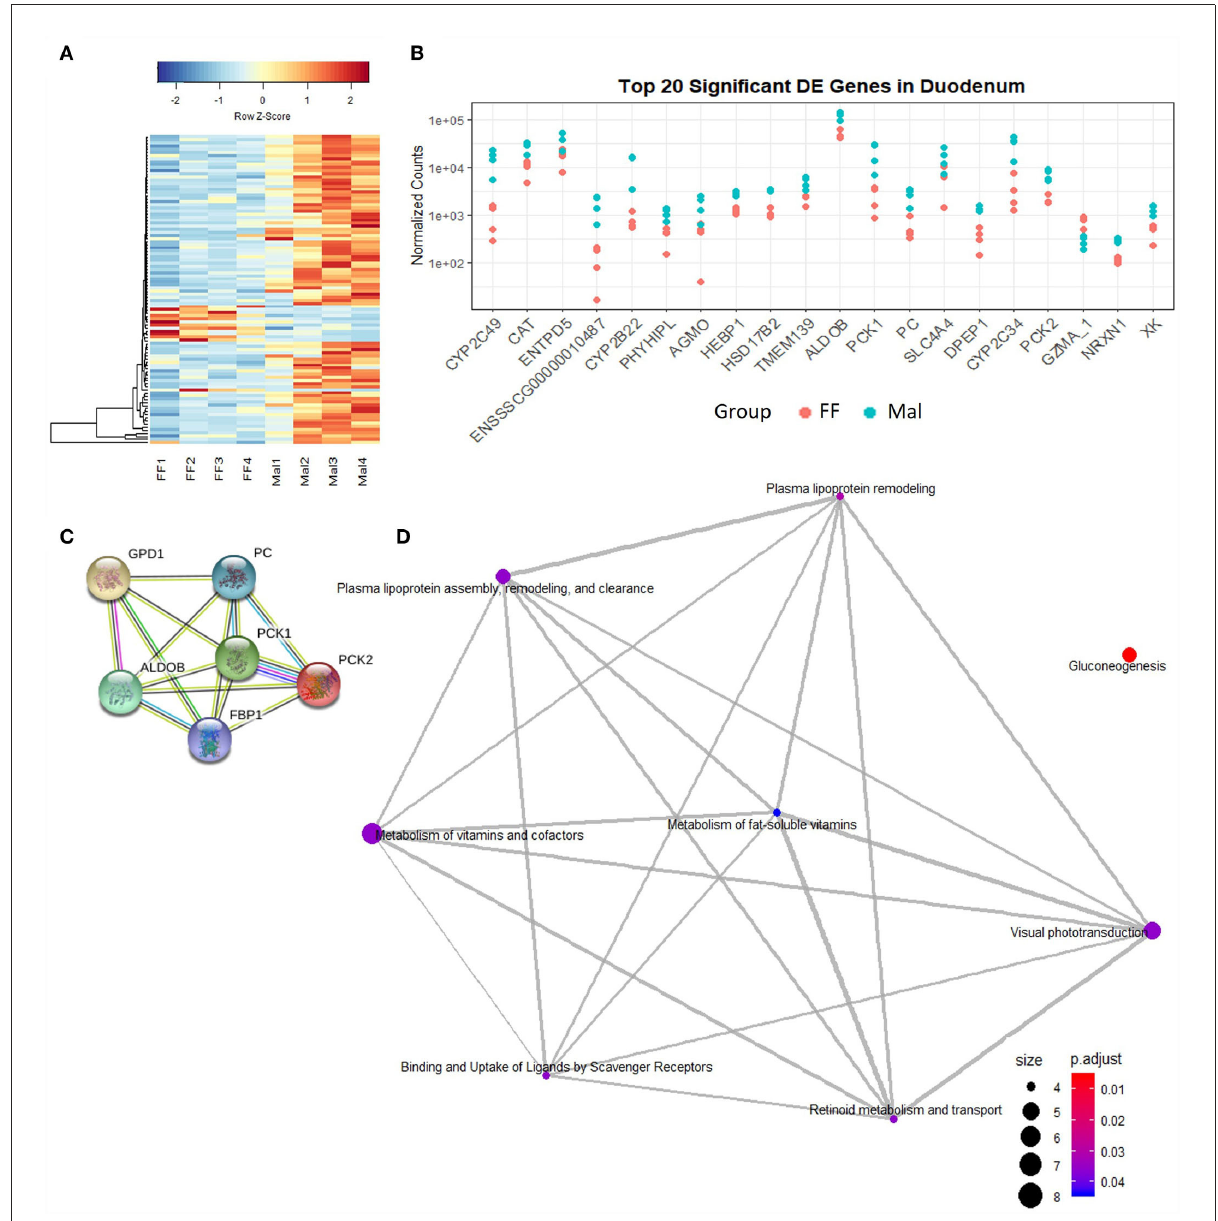
FIGURE2 Gene expression and pathway analysis in the duodenum of full-fed and malnourished pigs. (A) Heatmap with hierarchical supervised clustering of the normalized counts using Euclidean distance for the 100 DE genes with the greatest variance between the full-fed (FF, n = 4) and malnourished (Mal, n = 4) groups in the duodenum. Z-score represents upregulated (red) and downregulated (blue) genes, with a color gradient indicating expression level. (B) Plot of the normalized counts of the 20 genes with the lowest padj values in the duodenum of FF [ n = 4 (pink)] and Mal [ n = 4 (blue)] animals. The genes are ordered left to right from lowest to greatest padj values. (C) Pathways significantly enriched in the duodenum when comparing the FF and Mal groups using GO and STRING functional analysis of upregulated genes associated with gluconeogenesis. Edge colors represent connection source: text mining connection (yellow), co-expression (black), curated databases (light blue), and experimentally determined (pink). (D) Reactome pathway analysis using the DE in the duodenum entrez gene ID in humans. Edges connect associated pathways. The size and color of nodes represent the number of genes up or downregulated and padj values, respectively.